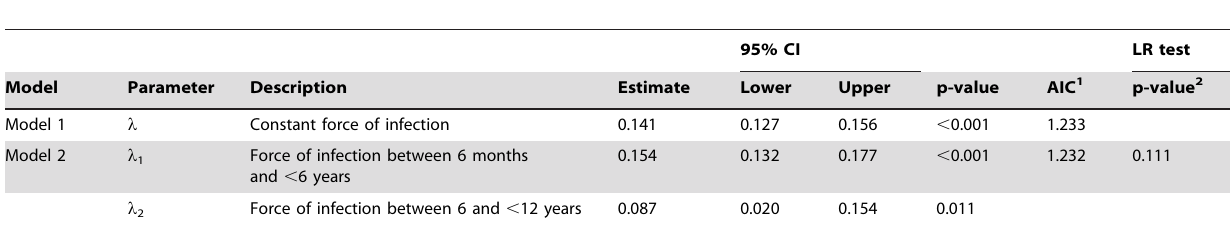
Table 2. Force of infection estimates for Models 1 (constant force of infection) and 2 (age-varying force of